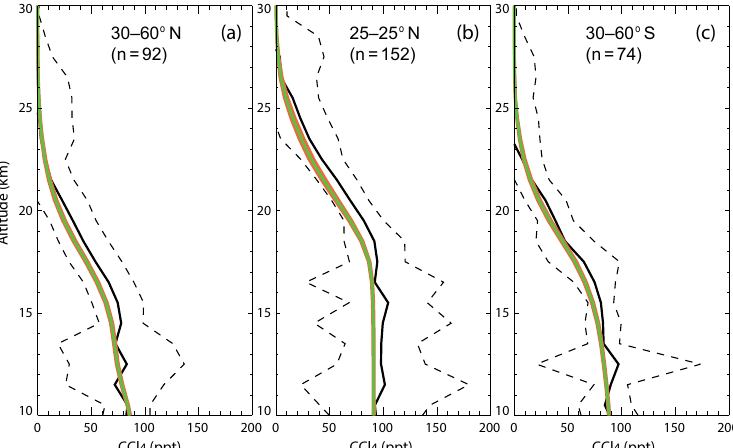
Figure 6. Mean profiles of CCl 4 from March to April 2005 as determined from the recent ACE-FTS research retrievals (Harrison et al., 2016) (black line) for latitude bands (a) 30–60 ◦ N, (b) 25 ◦ S–25 ◦ N and (c) 30–60 ◦ S. The number of observed profiles which contribute to the mean is given in the titles ( n ). The dashed lines show the standard deviation of the observations. Also shown are mean profiles from model control tracer CTC1 for the same latitude bins and time period (green line) and the range of values produced from sensitivity runs CTC6 and CTC7 with ± 10% change in CCl 4 photolysis rate (orange shading, difficult to see). Note that the model profiles are averages over the indicated spatial regions and are not sampled at the exact locations of the ACE-FTS measurements.